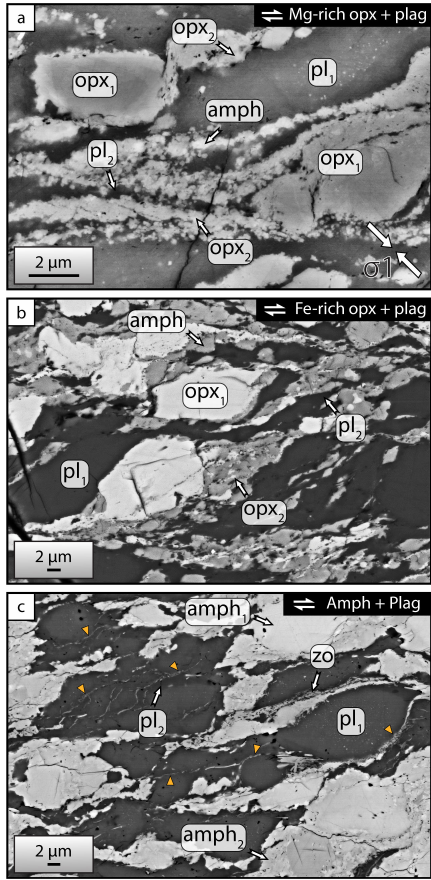
Figure 10. SEM BSE images of incipient nucleation and shear lo- calization. (a) In the Mg-rich opx + plag assemblages, fine-grained tails of mixed phases nucleate at the edges of original grains. In the Fe-rich opx + plag (b) and amph + plag (c) assemblages, the nu- cleation is fairly monophase. The new grains tend to organize into an anastomosing network of thin amphibole and zoisite (orange tri- angle). opx: orthopyroxene, pl: plagioclase, amph: amphibole, zo: